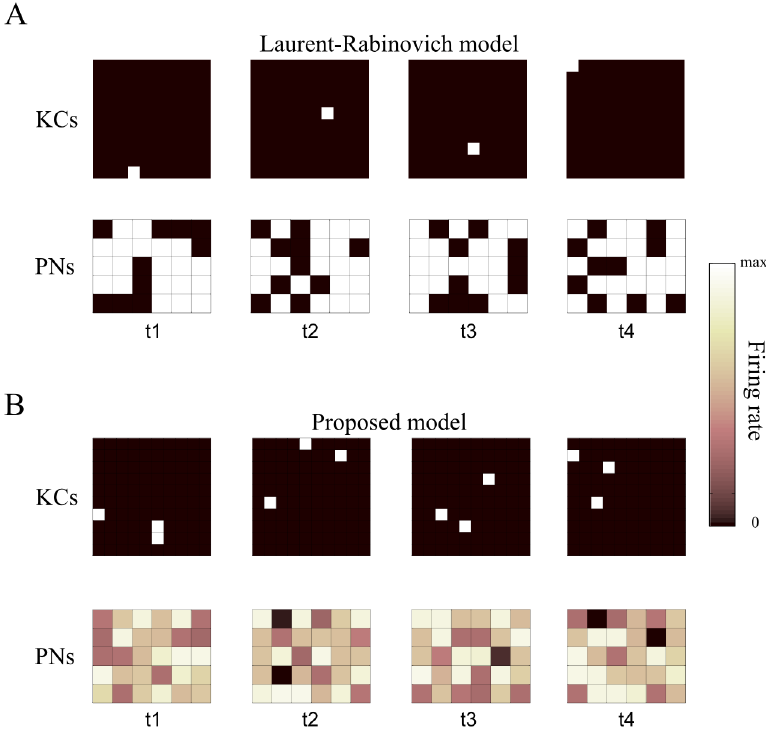
Fig 2. PN output of our model compared to the Laurent-Rabinovich model. Firing rates of 100 KCs and 30 PNs in mushroom body and the antennal lobe, respectively, for the proposed model and an implementation of the Laurent-Rabinovich model. Each panel represents the activity of the KC and PN populations at times t1, t2, t3 and t4, in which the clusters of the sequence are at their maximum value (see Fig 5), and each square in a panel represents a neuron (10x10 for KCs, 6x5 for PNs). (A) An SHS model, as presented in [11], used for the KC population, plus a random 1 KC to 20 PNs projection. (B) Data generated by the proposed model, with clusters of three KCs